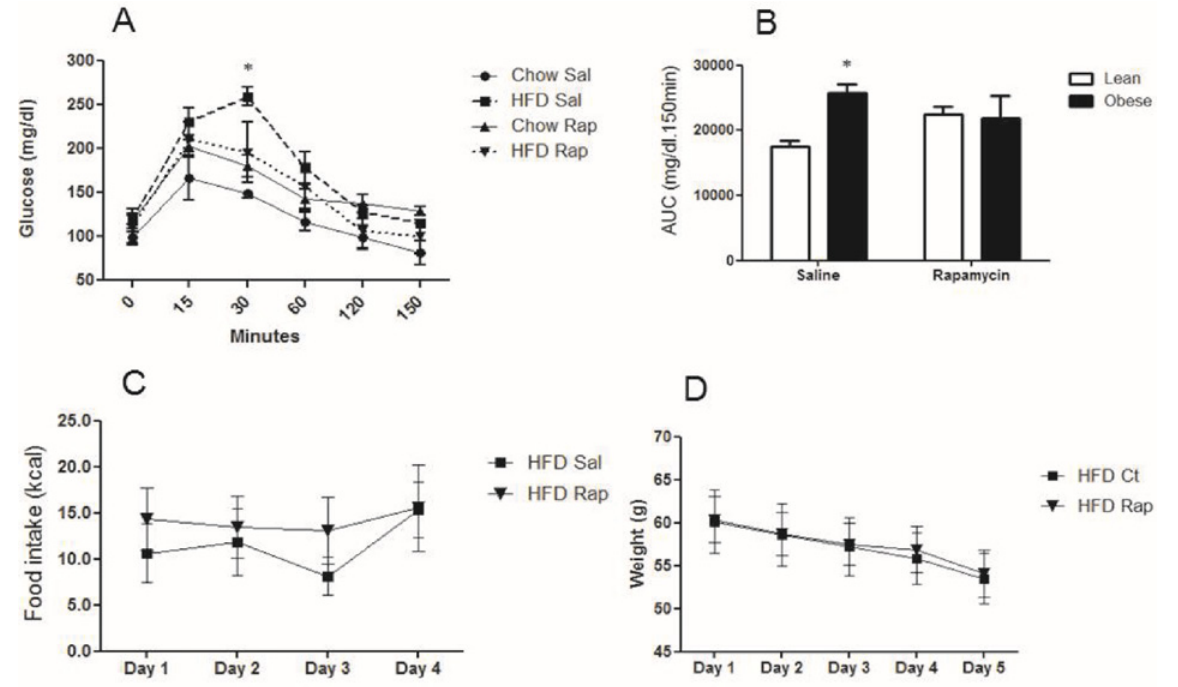
Fig 5. Metabolic parameters in mice treated with Rapamycin (icv). A and B . GTT curve and area under the GTT of lean or obese mice (16 weeks of a HFD) treated with 2 μ l of a solution that contained 25 μ M rapamycin (Rap) or saline (Sal) once a day for 6 days. C and D. Food intake and weight modulation in obese mice treated with rapamycin. HFD versus chow diet in mice treated with saline and a HFD in mice treated with rapamycin versus a HFD in mice treated with saline. Values are shown as mean ± SEM. * P < 0.05; n = 5 – 6 animals per group.